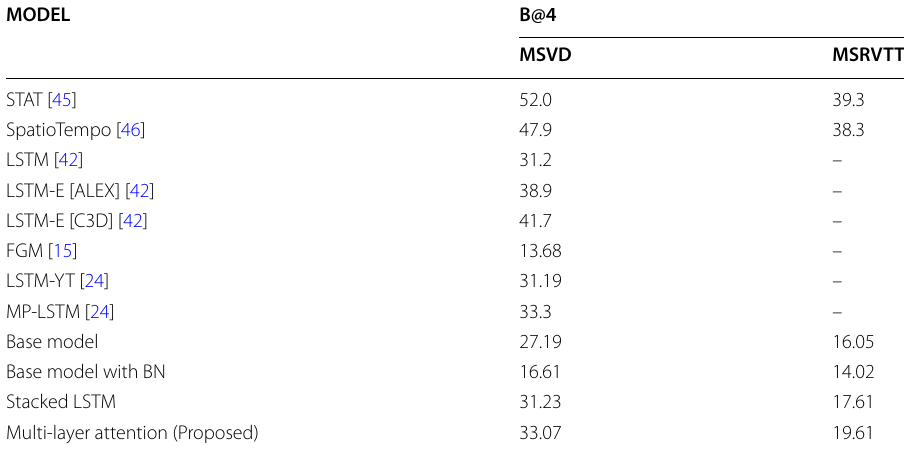
Table 3 Performance comparison of BLUE-4 Score[B@4] with state-of-the-art-methods MODEL B@4